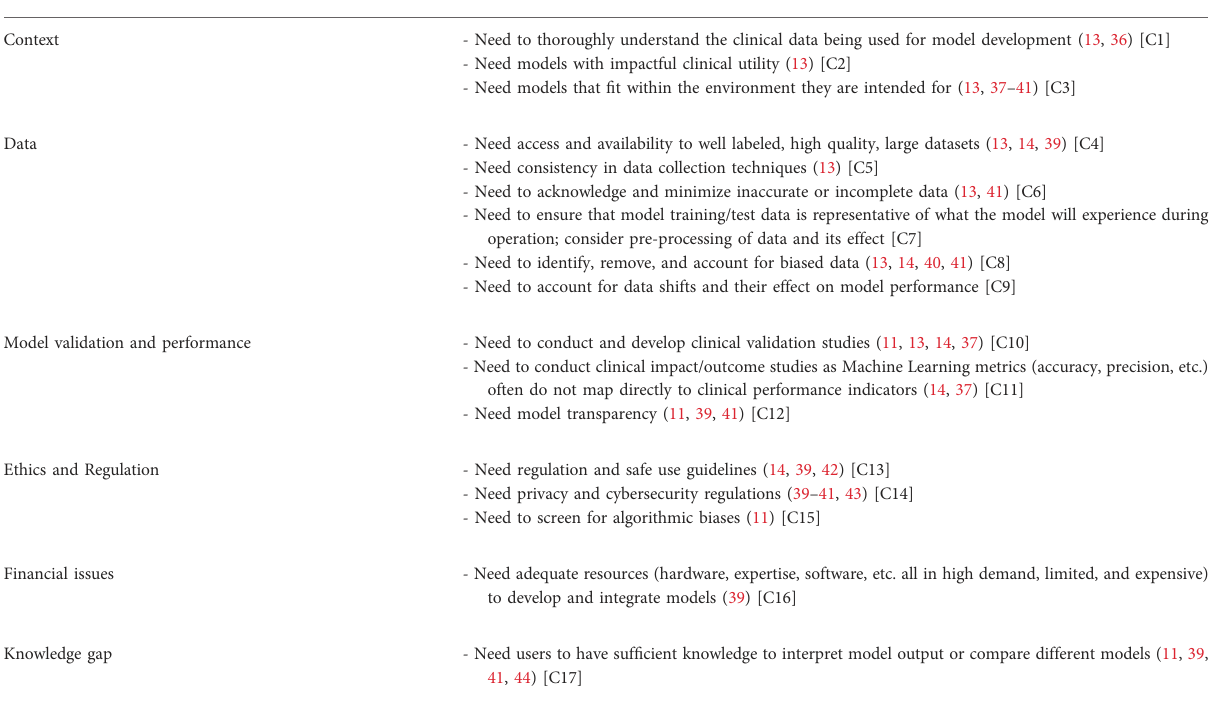
TABLE 4 Challenges with machine learning models in healthcare. Aspects of Machine Learning-models and the healthcare